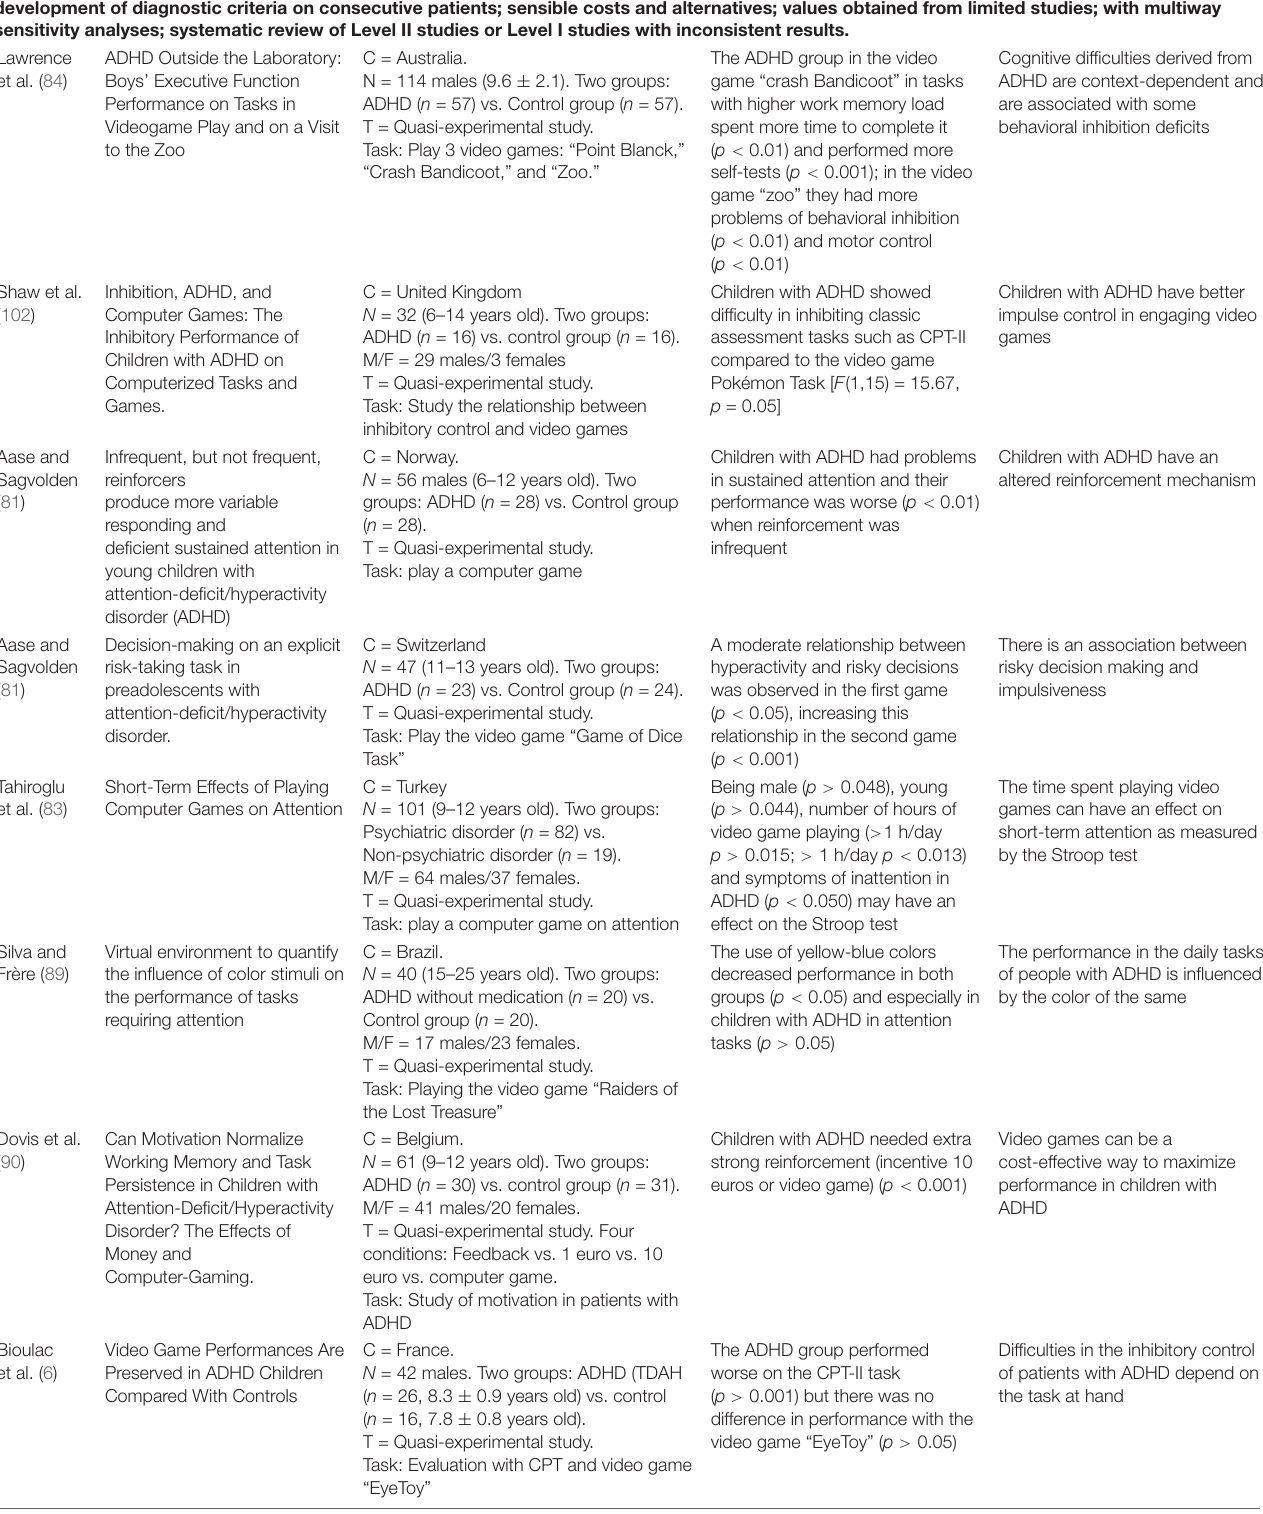
TABLE 3 | ADHD behavioral patterns with video game use. Level II: Lesser quality RCT; prospective comparative study; retrospective study; untreated controls from an RCT; lesser quality prospective study; development of diagnostic criteria on consecutive patients; sensible costs and alternatives; values obtained from limited studies; with